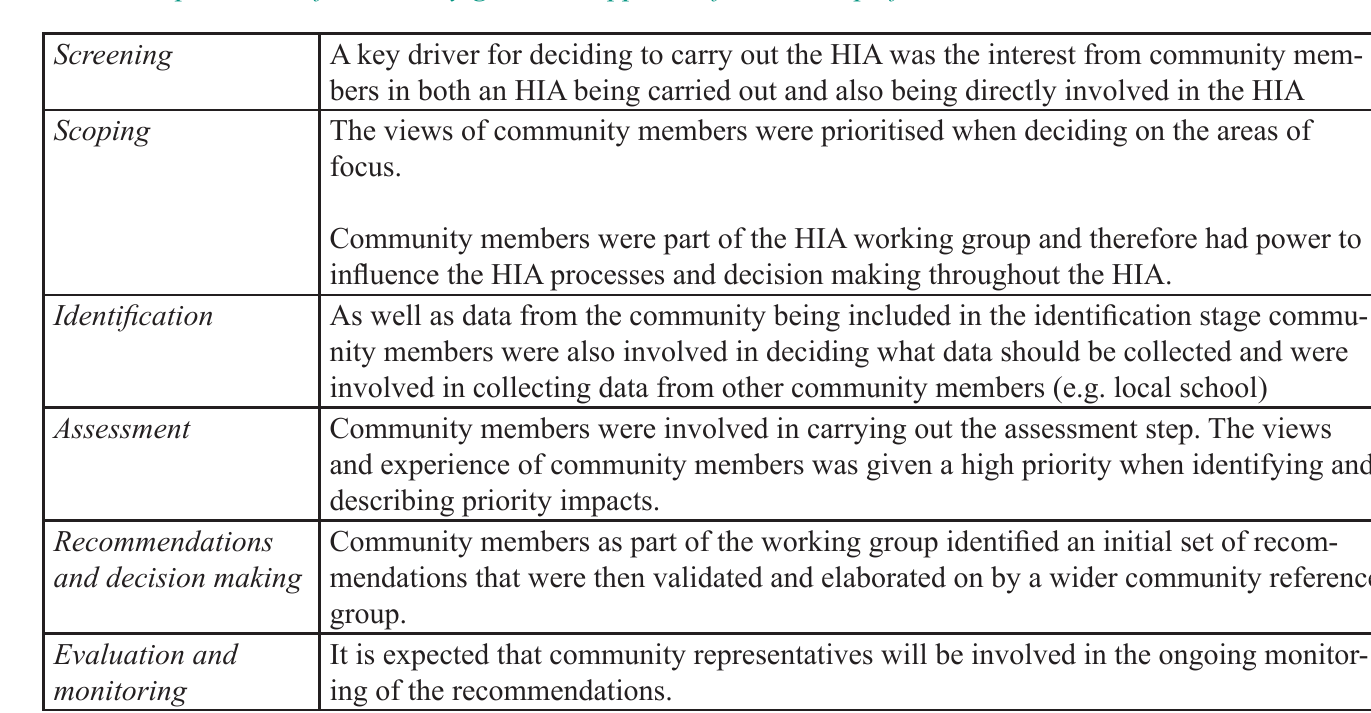
Table 4: Implications of community grounded approach for each step of the